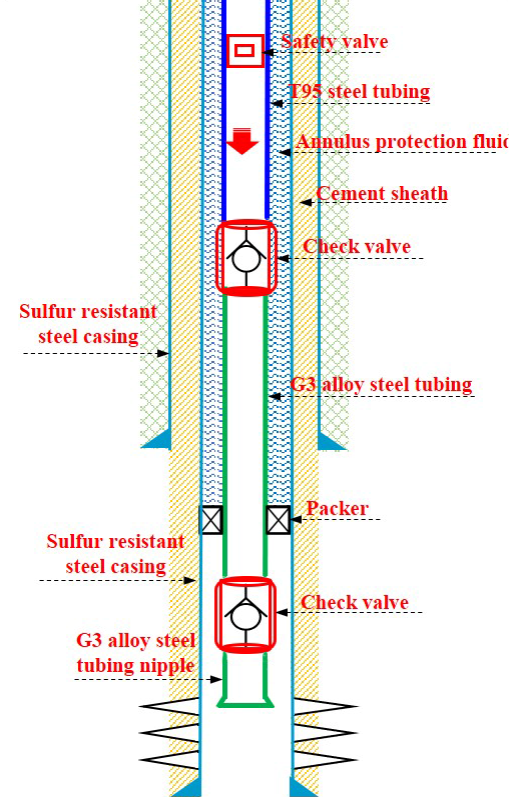
Figure 22. A new downhole packer for acid gas